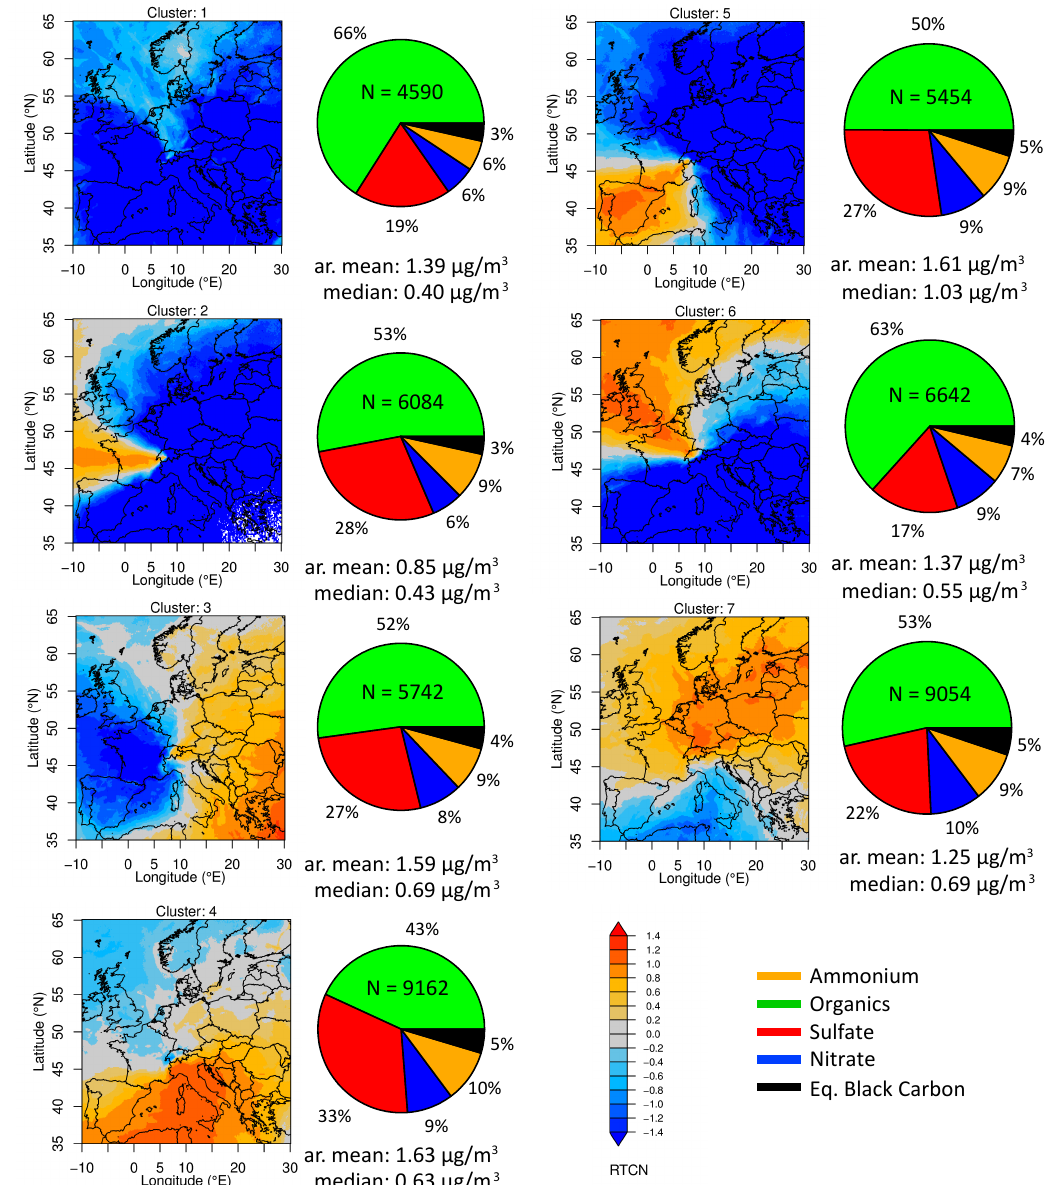
Figure 5. Aerosol footprint clusters with corresponding relative contributions of PM 1 organics (green), sulfate (red), nitrate (blue), ammo- nium (orange) and equivalent black carbon (black). Arithmetic mean as well as median total concentrations are given below each pie chart. The number N in each pie chart indicates the number of 10min averages included in the calculation of the mean and median. The unitless RCTN (residence times by cluster normalised) shows the normalised difference between cluster average and total average residence times. Positive (negative) values indicate increased (decreased) surface sensitivity compared to the overall footprint. The scale extends from − 2 to 2 with values larger than 1 (smaller than − 1), indicating regions with at least 3 times longer (shorter) residence times; for details, see Sturm et al.